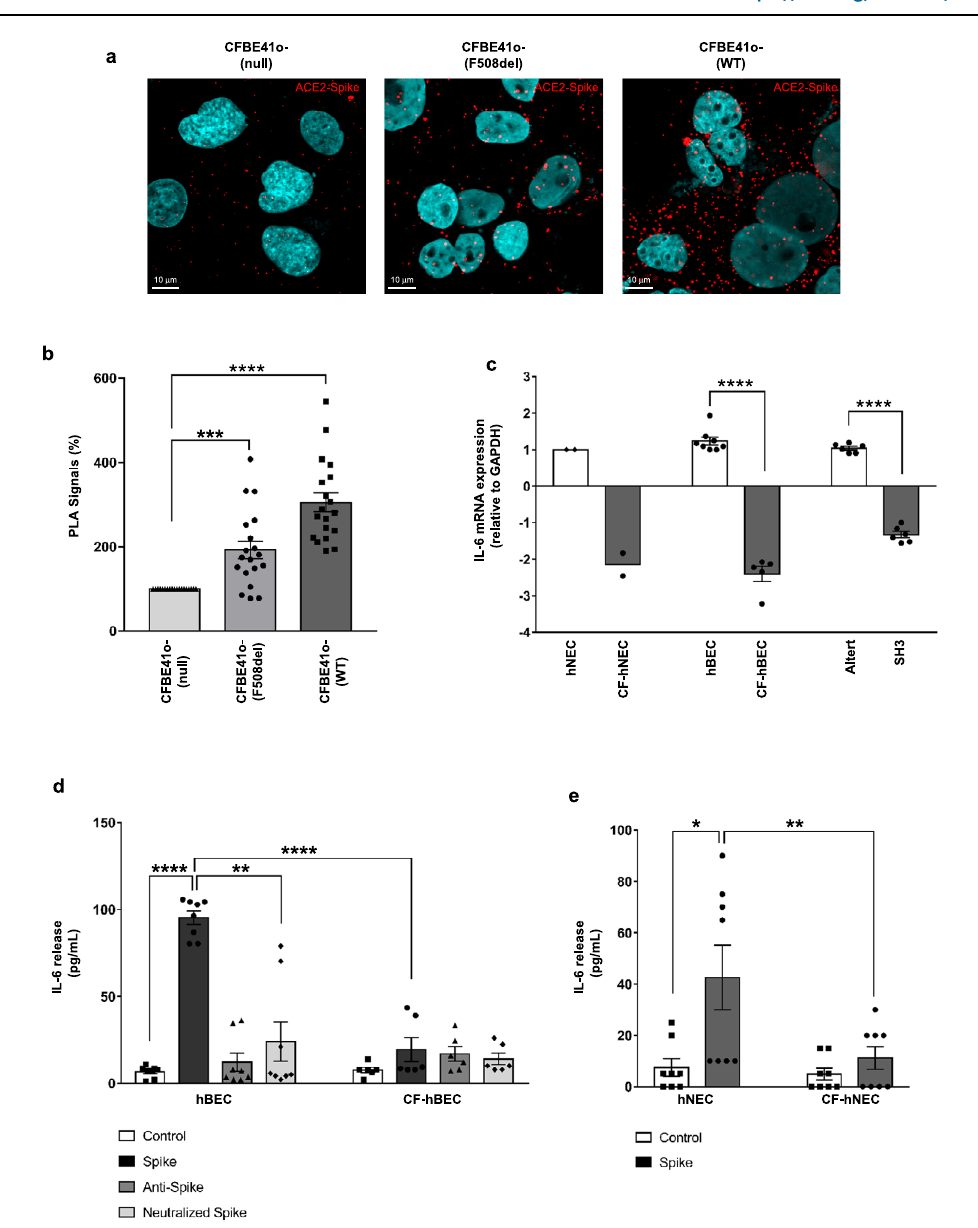
Fig. 7 | SARS-CoV-2 Spike binding to ACE2 is decreased in bronchial epithelial cellslackingCFTR expression and IL-6 release inducedby S proteinisreduced in CF. a Proximity ligation assay (PLA) for SARS-CoV-2 S protein and ACE2 inter- actions was performed in CFBE41o-, CFBE41o- (F508del) or CFBE41o- (WT). Representative images with PLA signals obtained from the binding of S protein to ACE2 (red) in different cells are shown. The cell nuclei were stained with DAPI (blue). b The scatter plot with bars shows quanti fi cation of PLA signals (%), with respect to CFBE41o- (null) cells ( n =19 independent visual fi eld for each condition of three independent experiments). c IL-6 mRNA was quanti fi ed by RT – qPCR in lysates obtained from differentiated hNEC cells obtained from a pool of fourteen healthy donors (hNEC, pool was indicated by ♦ ) versus two CF patients (CF-hNEC) homozygous for F508del CFTR or in primary hBEC obtained from healthy control subjects( n =8)versusCFpatientshomozygousforF508del CFTR ( n =5),orinAlter